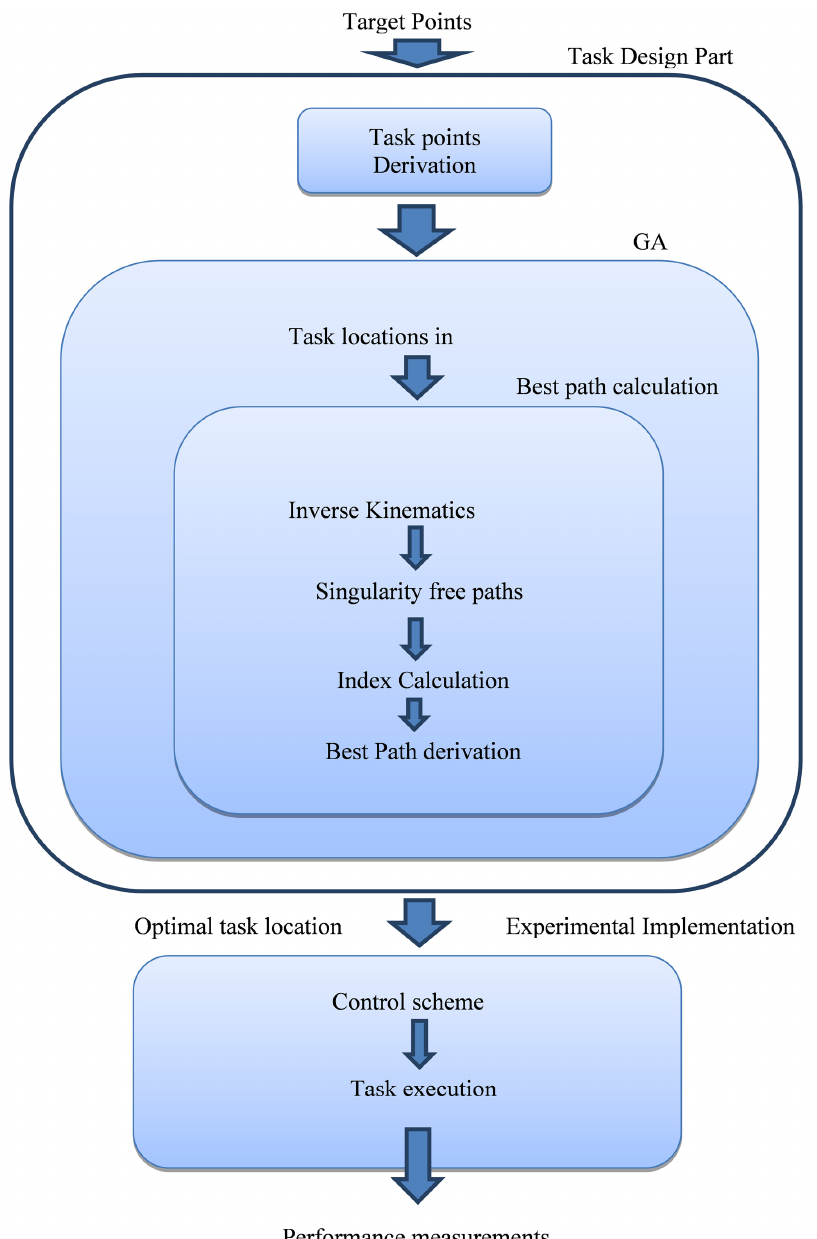
Figure 1. Process of the proposed method